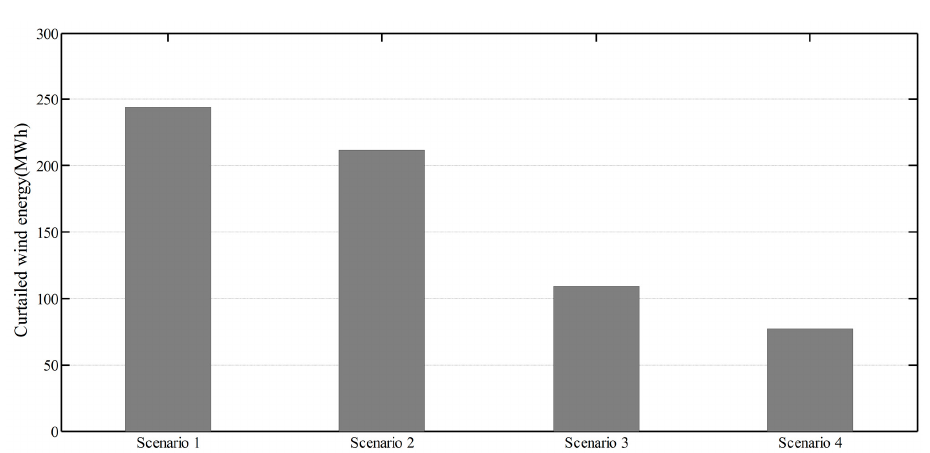
Figure 8. The total amounts of curtailed wind energy within 24 h in four scenarios.